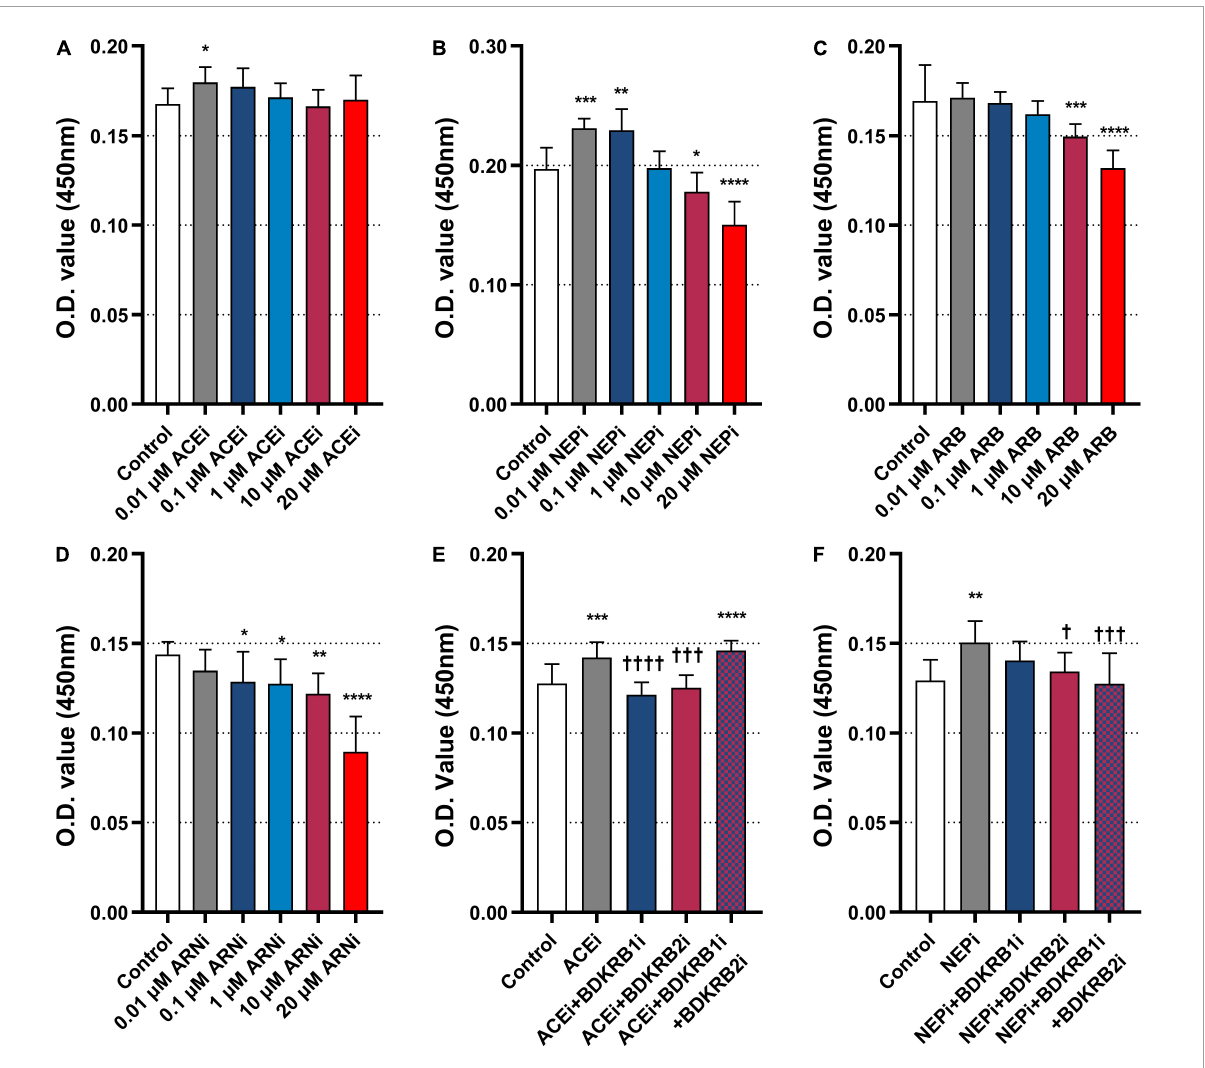
FIGURE6 Effects of ACEi, NEPi, ARB, ARNi, and antagonists of bradykinin receptors on MHEC5-T proliferation. (A–D) Effects of ACEi, NEPi, ARB, ARNi on MHEC5-T proliferation at different concentrations, * P ≤ 0.05, ** P ≤ 0.01, *** P ≤ 0.001, **** P ≤ 0.0001, compared to control. (E) Effects of ACEi and antagonists of bradykinin receptors on MHEC5-T proliferation. *** P ≤ 0.001, **** P ≤ 0.0001, compared to control. ††† P ≤ 0.001, †††† P ≤ 0.0001, compared to ACEi. (F) Effects of NEPi and antagonists of bradykinin receptors on MHEC5-T proliferation. ** P ≤ 0.01, compared to control. † P ≤ 0.05, ††† P ≤ 0.001, compared to